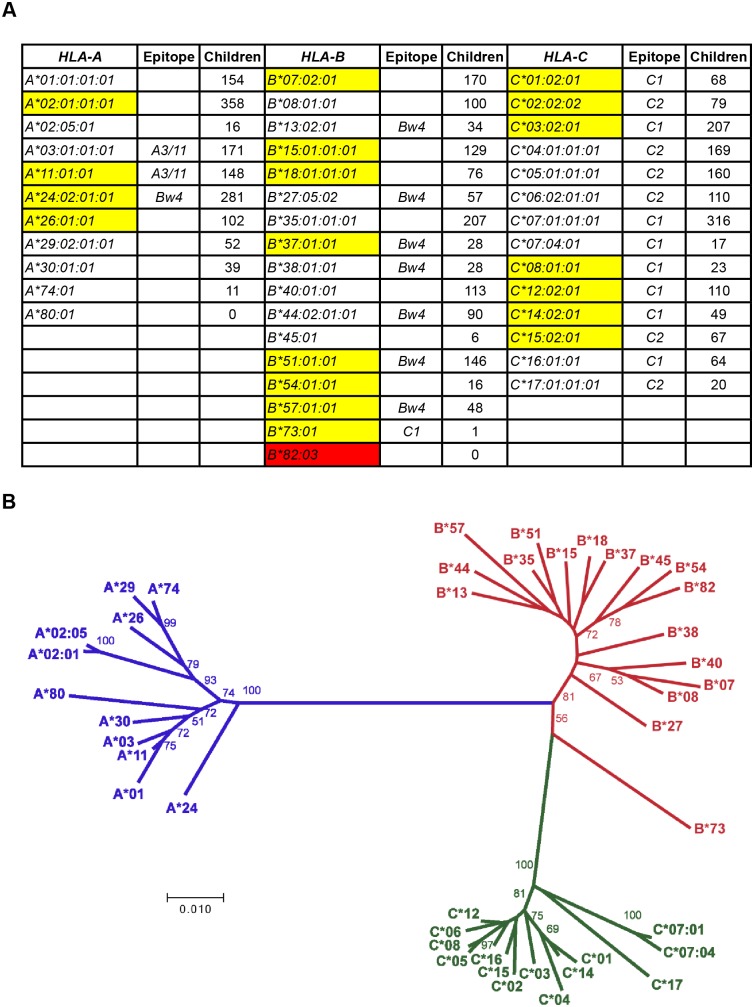
Core HLA-A, -B and –C alleles.A Starting with the 42 core alleles (11 HLA-A, 17 HLA-B and 14 HLA-C) it is possible to derive all the other HLA-A, -B and –C alleles by events of recombination and point mutation. This is the minimum number of alleles by which this can be achieved. The core alleles are not meant to represent any particular human population, either ancient or modern. The yellow shading indicates potential archaic alleles that have been transmitted from Denisovans or Neanderthals. Red shading indicates rare allele that does not have a frequency > 0.001 in more than one reference population. B An unrooted phylogenetic tree of the core alleles. Numbers at the nodes indicate bootstrap support. Where a number is absent, support at that node was < 50.